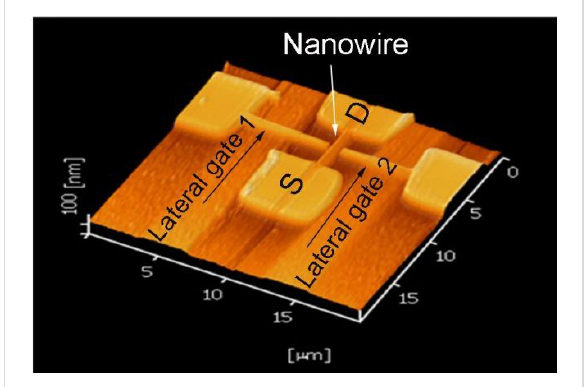
Figure 2: AFM topography image of the final structure.